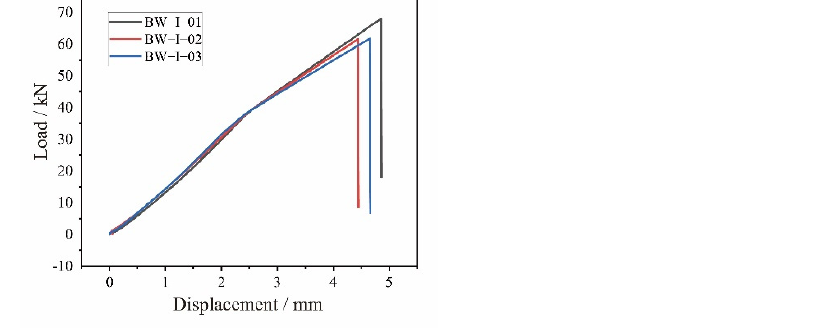
Figure 4. Load-displacement curves from the shear experiments on the PWF composite beams of BW-I. Table 4. Experimental results of the failure load and critical buckling load—The PWF composite beams of BW-I.